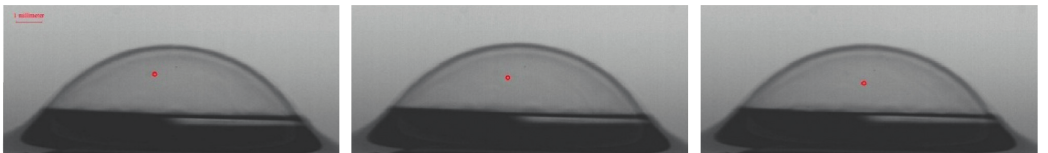
Figure 17: Visualization of particles moving on the cap.